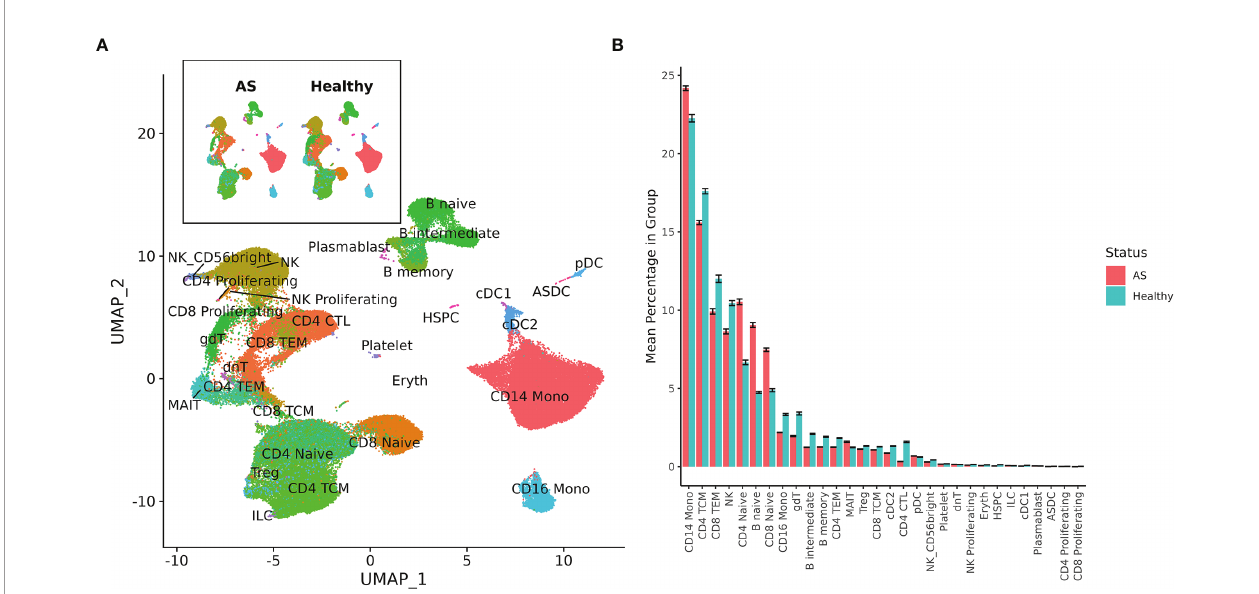
FIGURE 1 | Cell types among AS and healthy PBMCs. (A) UMAP of 30 cell types in AS and healthy PBMCs based on RNA expression. (B) Mean percentage of each cell type within the total PBMCs from each subject, averaged across AS and healthy cohorts. Error bars represent standard error of the mean. When tested for statistical signi fi cance using the Wilcoxon rank-sum test, CD4+ cytotoxic T cells and hematopoietic stem and progenitor cells were signi fi cantly underexpressed in